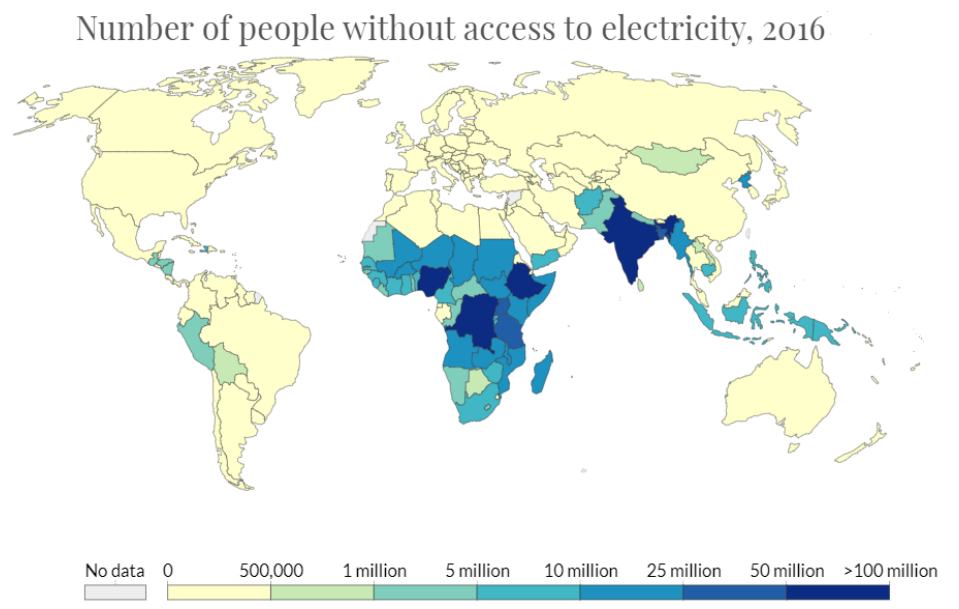
Figure 1. Global population without access to electricity by country in 2016 [2].